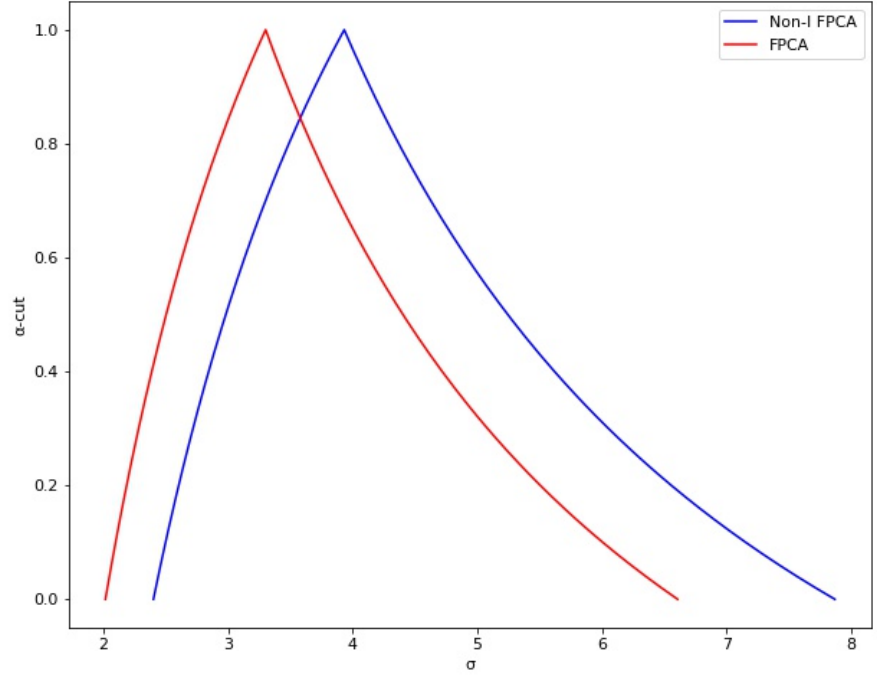
Figure 11. The membership function of 𝜎(cid:3548) (cid:3030)